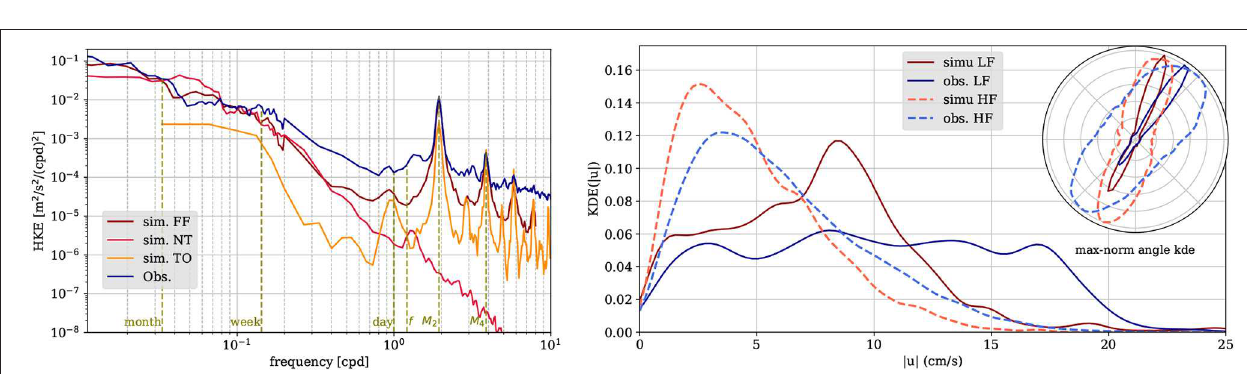
FIGURE 7 | Left column: Horizontal Kinetic Energy Power Spectral Density, and right column: Kernel Density Estimates of low-pass filtered velocity magnitude and angle (polar-coordinate insets, normalized by the max value of the distribution to improve readability), in the Rainbow overflow (upper row) and downstream in the AMAR segment (lower row), from the numerical simulations (red/orange colors) and in-situ observations (blue).